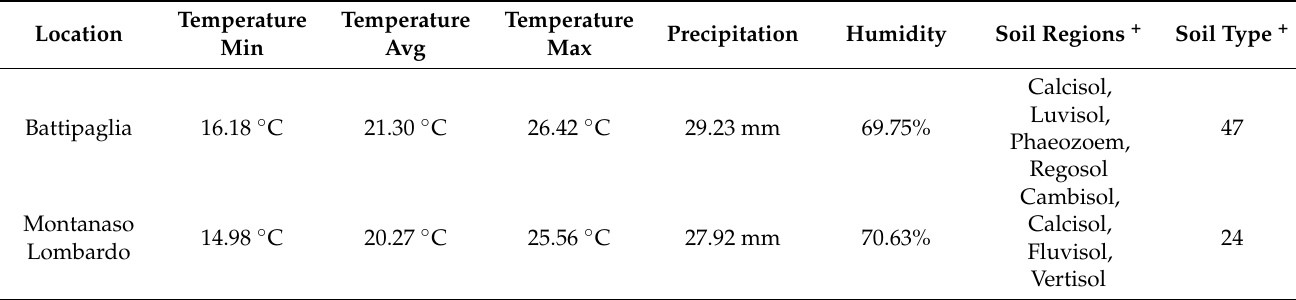
Table 1. Pedoclimatic characteristics of the two cultivation environments of the present study. For temperature, precipitation and humidity, the mean values of the year of cultivation (2014) are